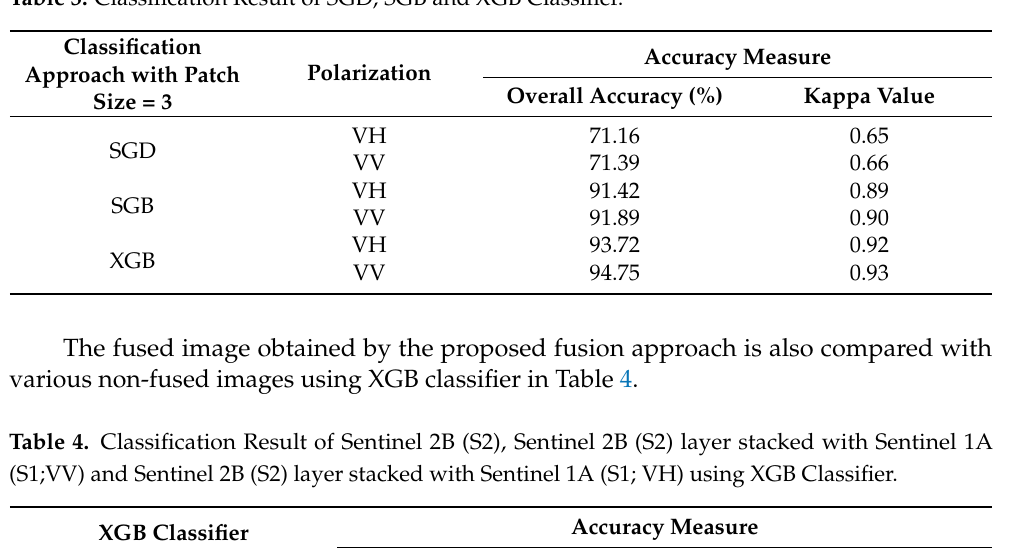
Table 3. Classification Result of SGD, SGB and XGB Classifier.